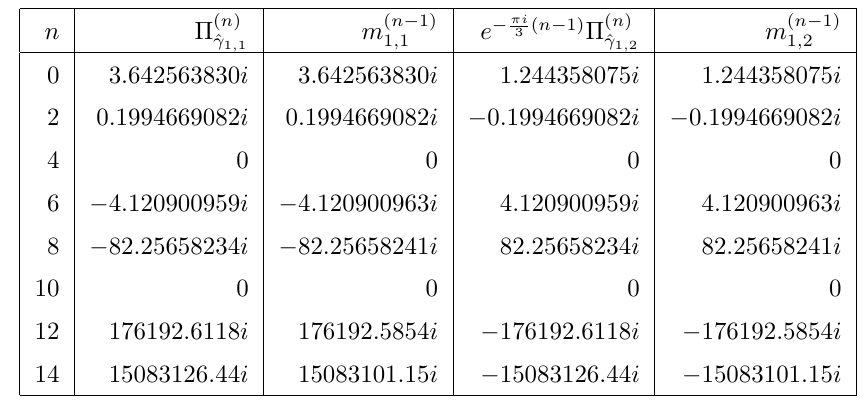
Table 3. Π ( n ) and m ( n − 1) ( s = 1 , 2) for the third order ODE with p ( x ) = − x 3 + x 2 + 2 x . The 1 ,s ˆ γ 1 ,s branch points are x 0 = 2 , x 1 = 0 , x 2 = − 1 . Here we have denoted the mass term m a,s by m ( − 1) a,s